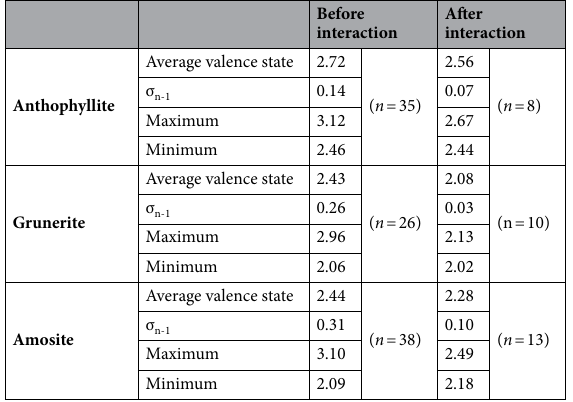
Before interaction